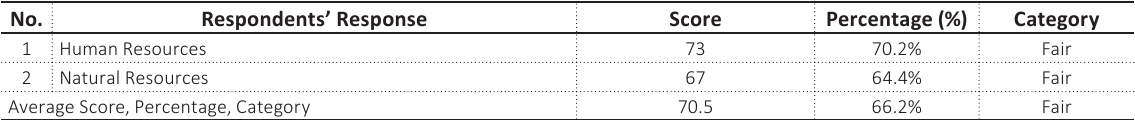
Table 6. Recapitulation of village heads’ leadership management in soft skill development of coastal area community potentials based on village innovation system in Bilato District